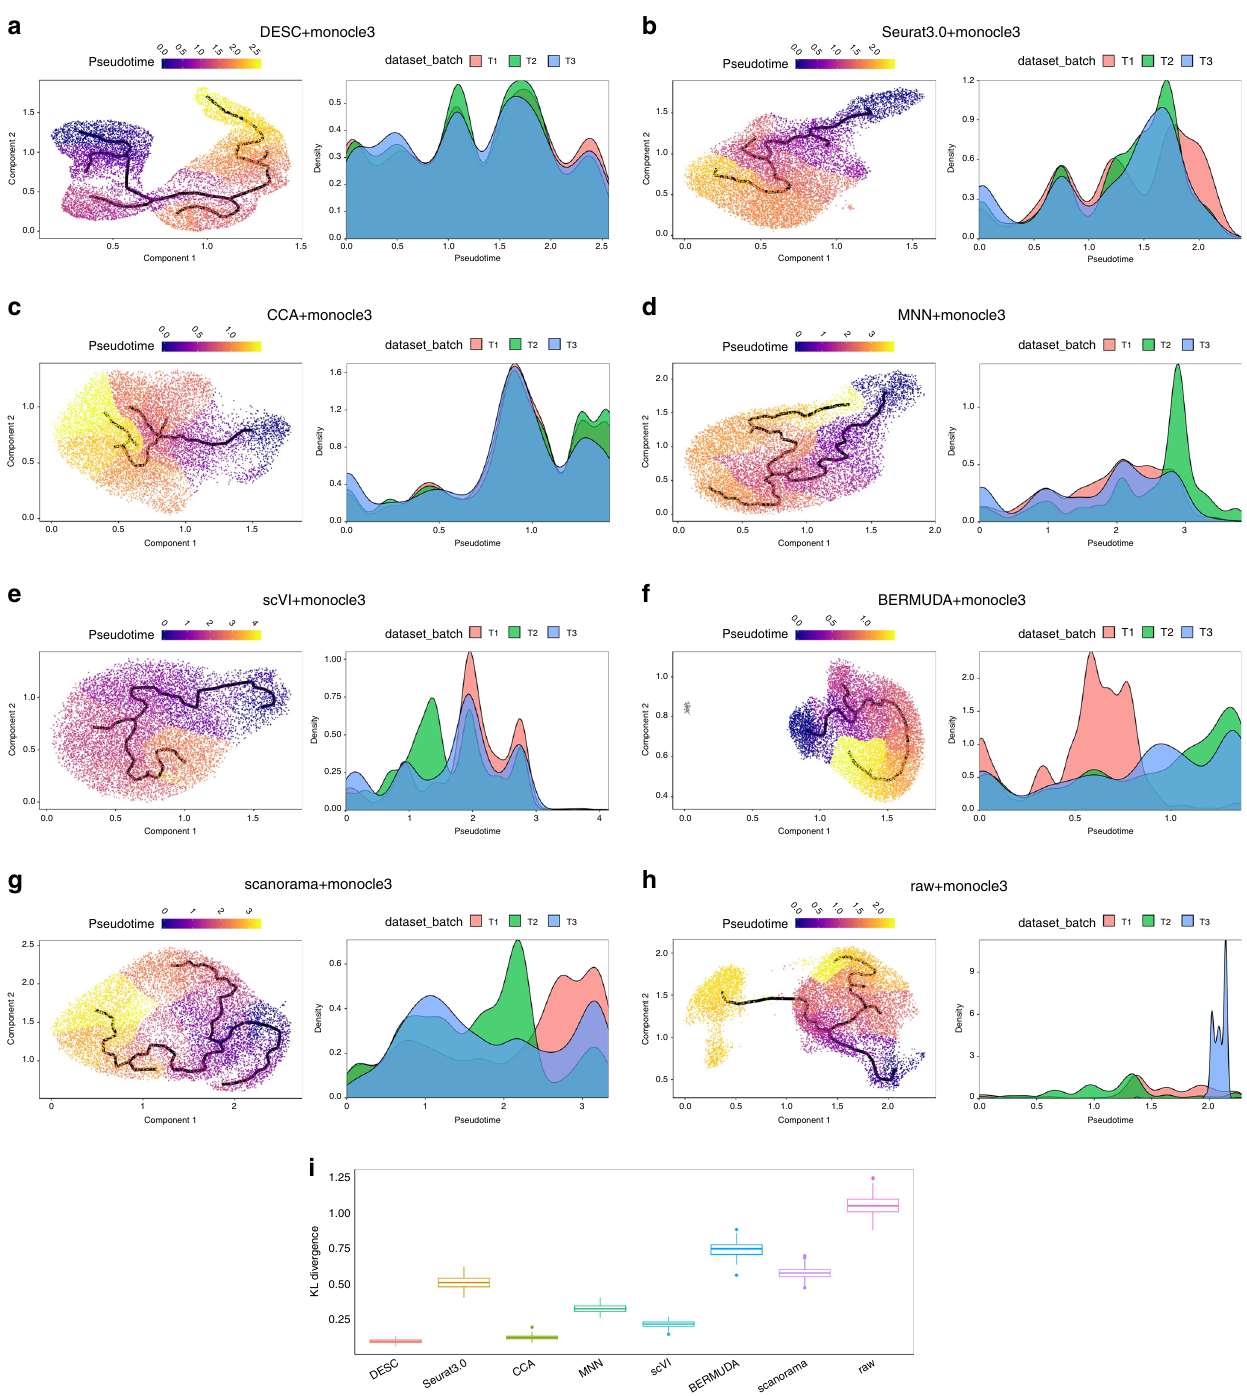
Fig. 7 The estimated pseudotime plots for the human monocyte data. Shown are the results of Monocle3 estimated pseudotime using a low-dimensional representation from DESC as input; b CCA components from Seurat 3.0 as input; c CCA components from method CCA as input; d PCA components of corrected gene expression values from MNN as input; e low-dimensional representation from scVI as input; f low-dimensional representation from BERMUDA as input; g low-dimensional representation from scanorama as input; h raw gene count matrix as input. Default parameters in Monocle3 were used to conduct dimension reduction and pseudotime estimation. i KL divergences that measure of the degree of batch effect removal for different methods. “ Raw ” represents the output of Monocle3 using the raw gene count matrix as the input. The box represents the interquartile range, the horizontal line in the box is the median, and the whiskers represent the 1.5 times interquartile range. Methods recognition, in which clear gains have resulted from joint consideration of the The DESC algorithm . Analysis of scRNA-seq data often involves clustering of cells classi fi cation and feature selection problems by deep learning. However, for scRNA-seq data, a challenge is that we cannot train deep neural network with into different clusters and selection of highly variable genes for cell clustering. As labeled data as cell-type labels are typically unknown. To solve this problem, we these are closely related, it is desirable to use a data driven approach to cluster cells take inspiration from recent work on unsupervised deep embedding for clustering and select genes simultaneously. This problem shares similarity with pattern NATURE COMMUNICATIONS| (2020) 11:2338